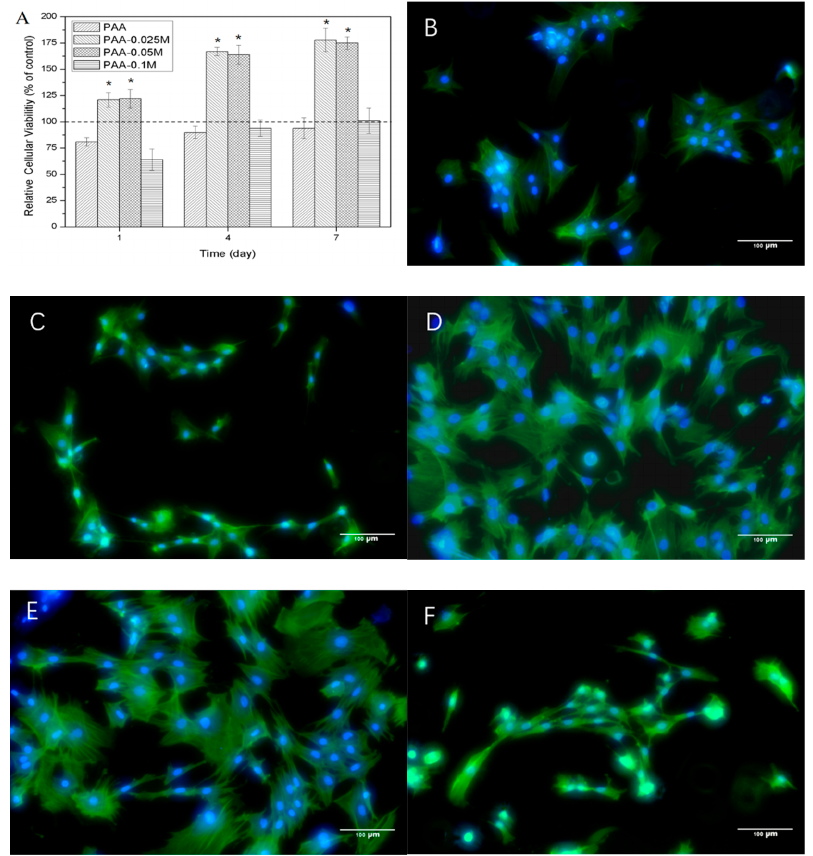
Figure 4. The relative cell viability and morphology of BMSCs cultured with Zn–PAA and PAA. ( A ) The cell viability of BMSCs cultured with Zn–PAA and PAA at 1, 4 and 7 days detected by cck-8 kit. (* p < 0.05 compared to PAA and PAA–0.1M); the morphology of BMSCs at 4 days of incubation cultured with ( B ) black control; ( C ) PAA; ( D ) PAA–0.025M; ( E ) PAA–0.05M; and ( F ) PAA–0.1M. The scale bar: 100 μ m.